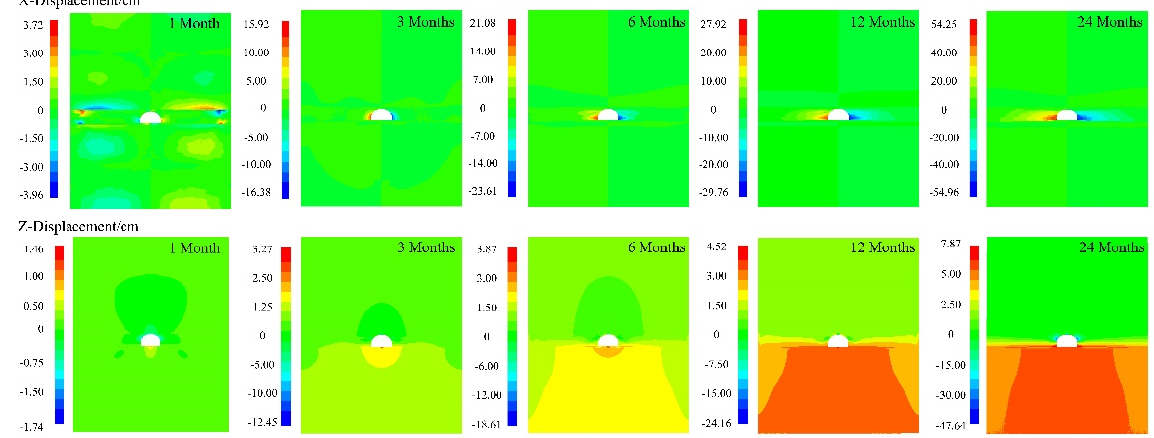
The creep deformation evolution process of the surrounding rock was long, and took 24 months for analysis and a 1-month interval for calculation. The horizontal and vertical displacement nephogram of representative time points can accurately reflect the site situation, as shown in Figure 19.